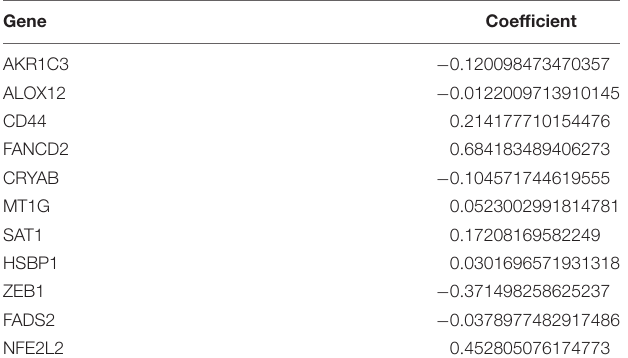
TABLE 1 | The calculated coefficient of the 11 ferroptosis-related